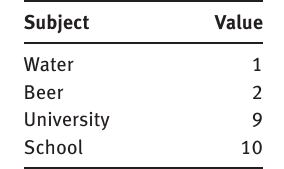
Table 1: Initial Values Attributed to Subjects.